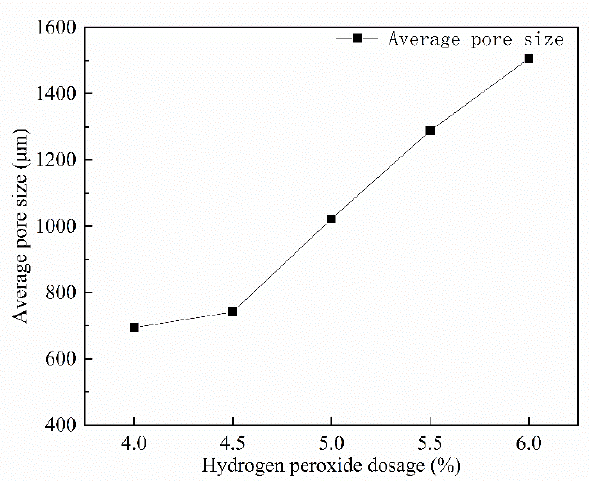
Figure 11. Effect of foam dosing on porosity.